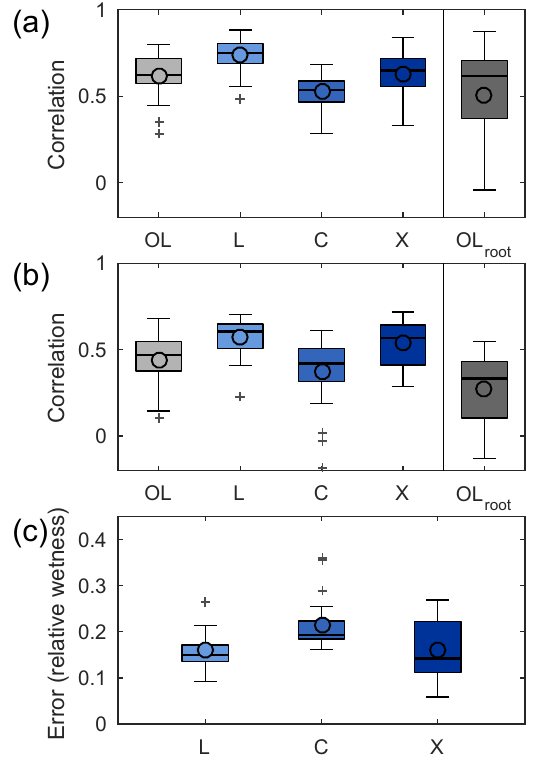
Figure 3. Evaluation of top-layer open-loop model soil mois- ture (OL) and satellite soil moisture observations against field measurements based on correlations ( r ) between July 2012 and April 2015 (a) and the same using anomaly time series (b) . Cor- relations ( r ) between root-zone open-loop model and root-zone field measurements are also shown. The triple collocation errors for the satellite soil moisture retrievals in AWRA-L wetness units are shown in (c) . Box plots show the inter-quartile range (box), outliers ( + ), the median (thick line), and the mean (o). Outliers are based on points at a distance larger than 1.5 times the inter-quartile range from the first and third